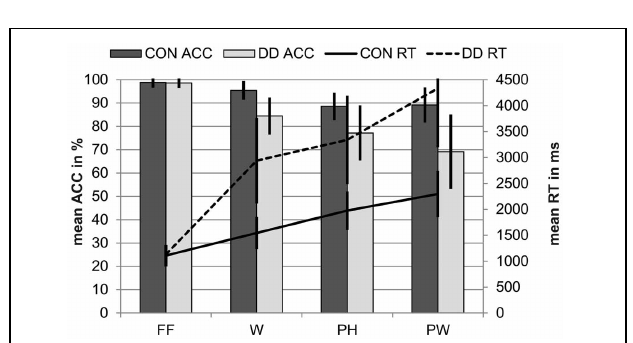
FIGURE 7 | Behavioral results for the PLD—task for control children (CON) and children with DD (DD). ACC, accuracy; RT, reaction time; FF, false fonts; W, words; PH, pseudohomophones; PW, pseudowords. Error bars illustrate standard